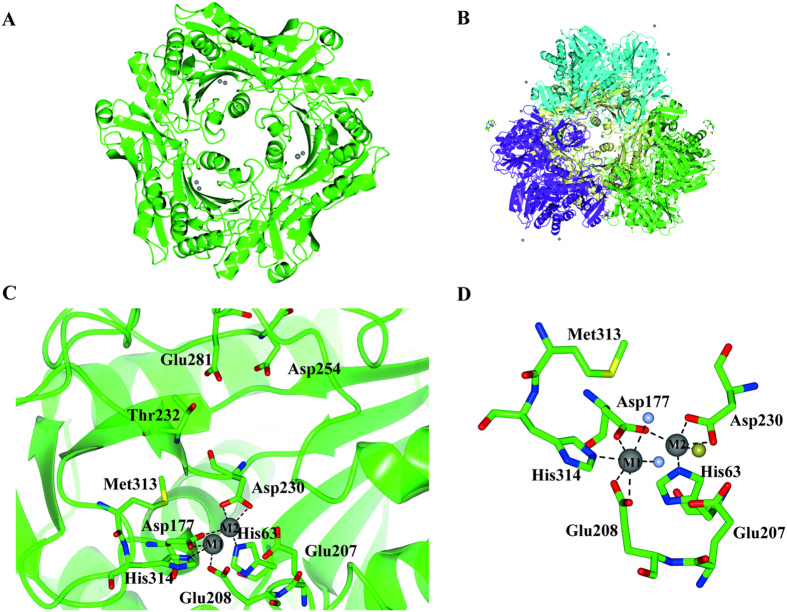
Structural features of PfTET3.(A) PfTET3 trimer in the asymmetric unit. The three monomers are almost identical with an r.m.s.d of 0.18 Å over the three chains. (B) PfTET3 dodecameric assembly obtained by applying the symmetry operators. Each trimer is highlighted by a different color (violet, green, yellow and cyan). Grey spheres represents metal ions. The sticks represent the DO3A bound to the Gd atoms. (C) Dinuclear active site and specificity binding pocket of one monomer. M1 site is coordinated by Asp177, Glu208 and His314 and M2 site is coordinated by His63, Asp177 and Asp230 (grey spheres). The identity of each metal ion is unknown. The specificity binding pocket is formed by Thr232, Asp254 and Glu281. (D) Zoom of the dinuclear metal center. Grey spheres are M1 and M2, gold sphere is Cl− and ice blue spheres are water molecules. M1 has an octahedral geometry while M2 has a trigonal bipyramidal geometry.